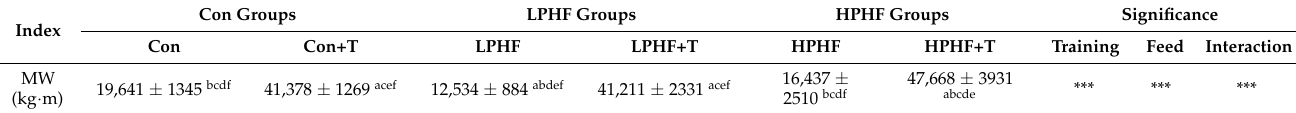
Table 2. Effects of LPHF, HPHF and/or training on maximal exercise workload after training intervention.